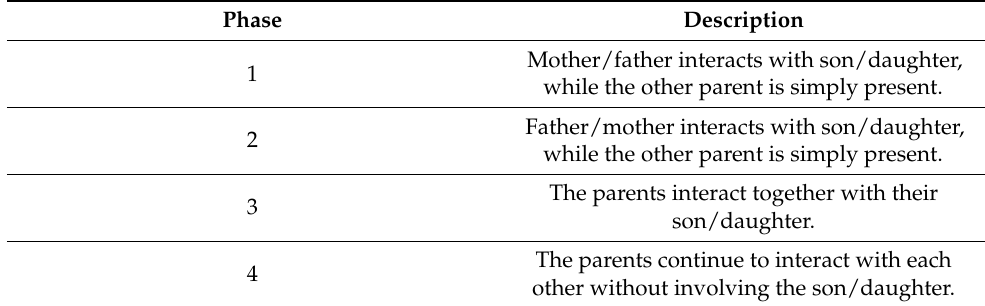
Table 1. Description of LTPc